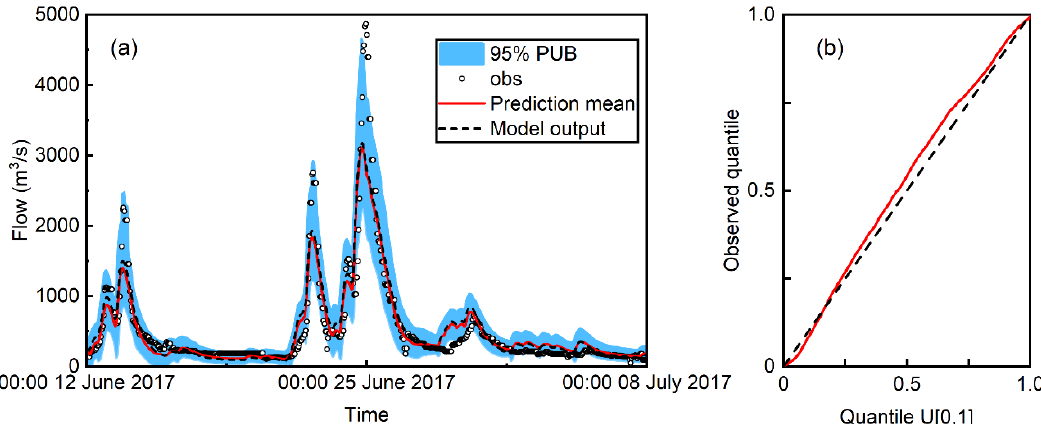
Figure 9. Typical examples of probabilistic streamflow predictions in the Changshangang River Basin for the ‘KA’ scenario: ( a ) mean and the 95% PUBs for the flood prediction with deterministic model output and flood observations; ( b ) PQQ plot for all simulated flood events.